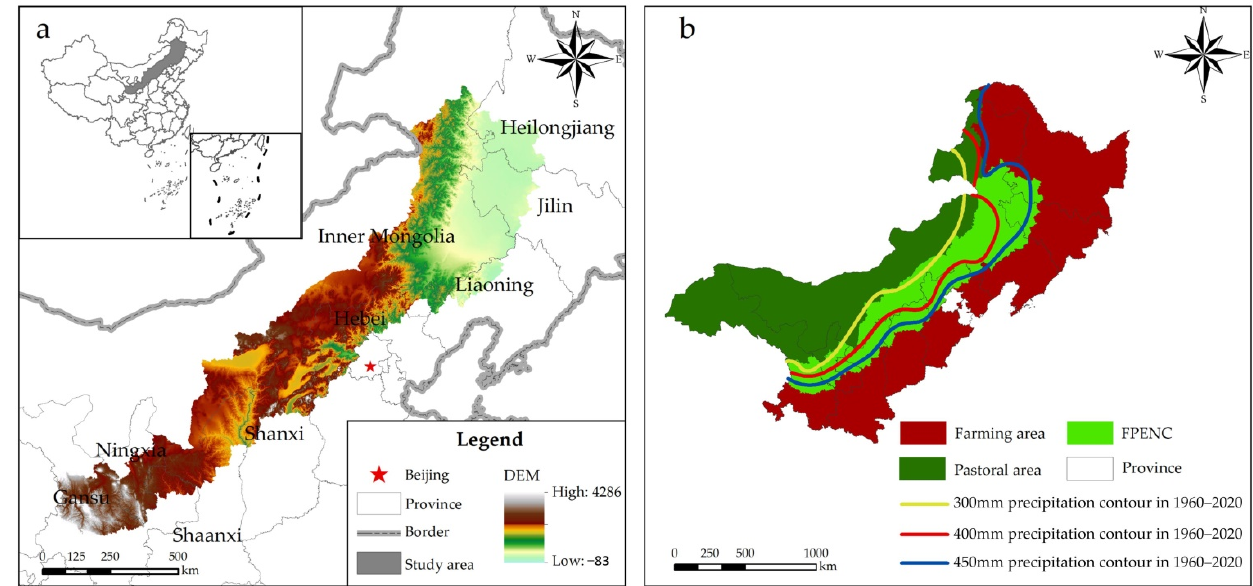
Figure 1. Geographical location and elevation ( a ) and the definition ( b ) of the farming – pastoral ecotone of northern China.